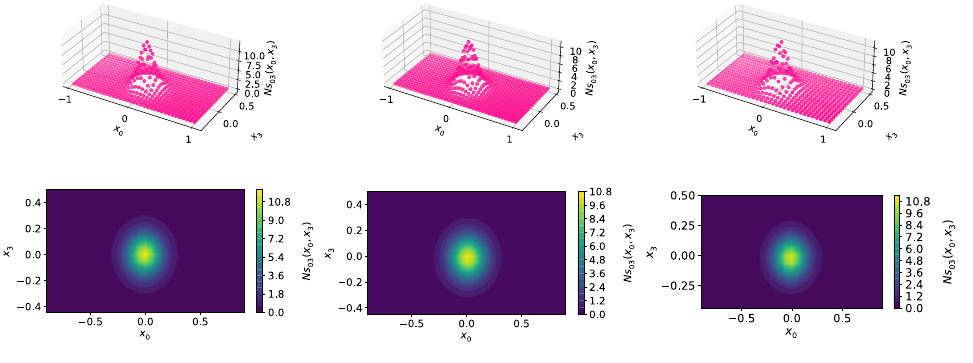
= l = l ( s = 1 ). Gauge groups are, from left 0 3